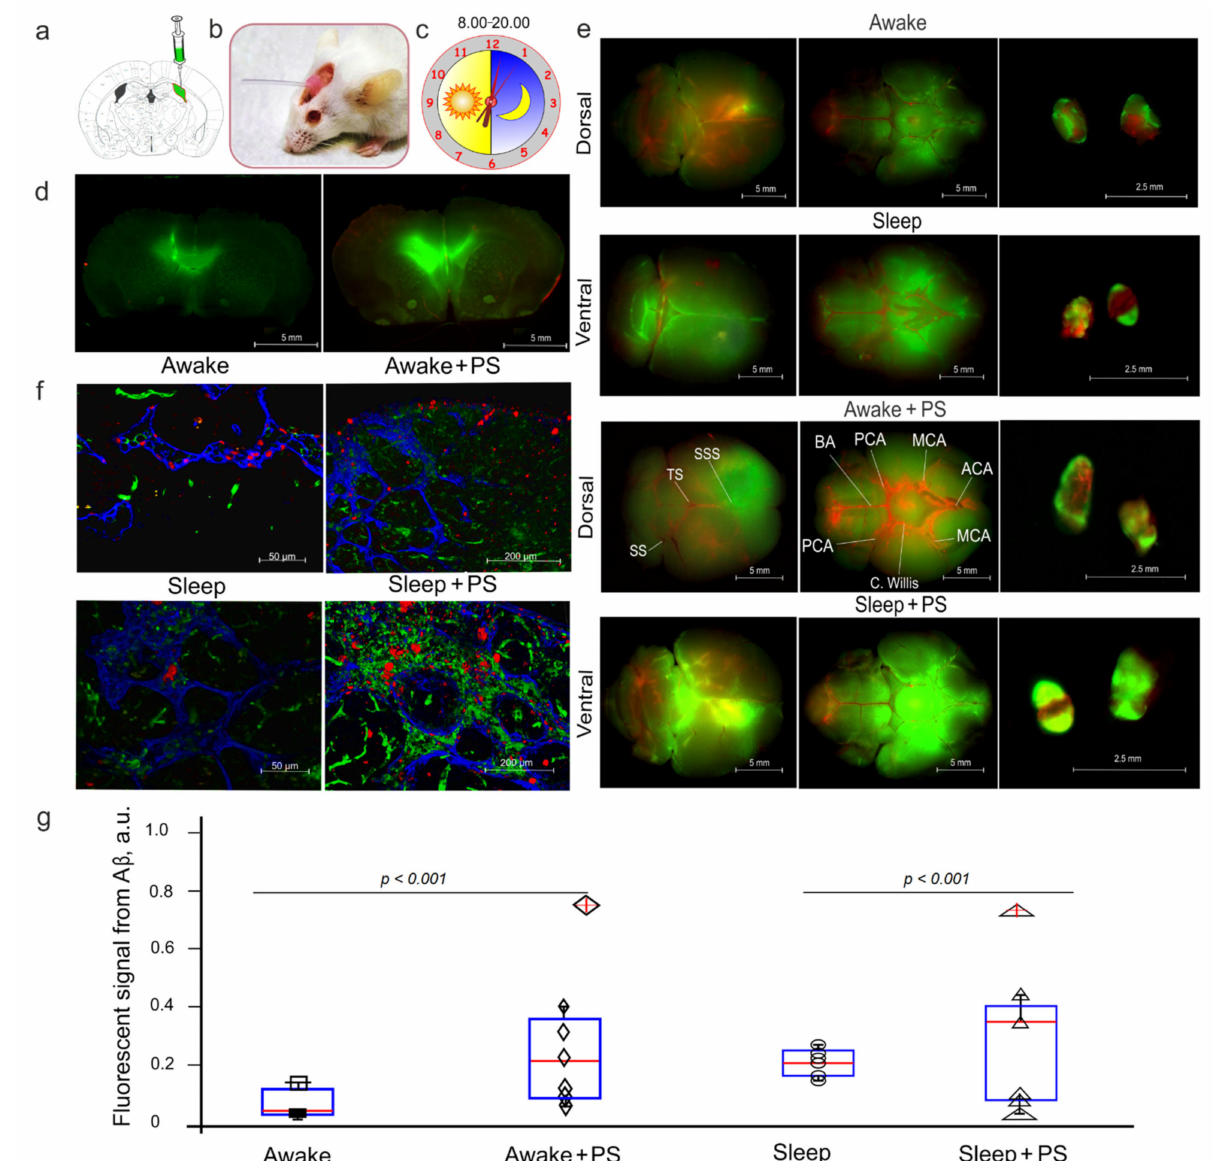
Figure 2. Photostimulation of the lymphatic clearance of FA β in sleeping and awake mice: ( a ) schema of the intraventricular injection of Fa β , ( b ) representative image of a mouse with an implanted catheter in the right later ventricle, ( c ) The time of the intraventricular injection of Fa β , ( d ) brain sections of the intraventricular injection of Fa β , ( e ) representative images of the distribution of FA β in the dorsal and ventral aspects of the brain and the accumulation of FA β in dcLNs 3 h after the intraventricular injection of FA β in the four tested groups, ( f ) representative images of the presence of FA β in the Lyve1/Prox1 lymphatic vessels of dcLNs 3 h after the intraventricular injection of FA β in the four tested groups, ( g ) quantitation of the signal intensity of FA β in the four tested groups (the two-sample Welch’ t -test and nonparametric Mann–Whitney U tests, n = 7 in each